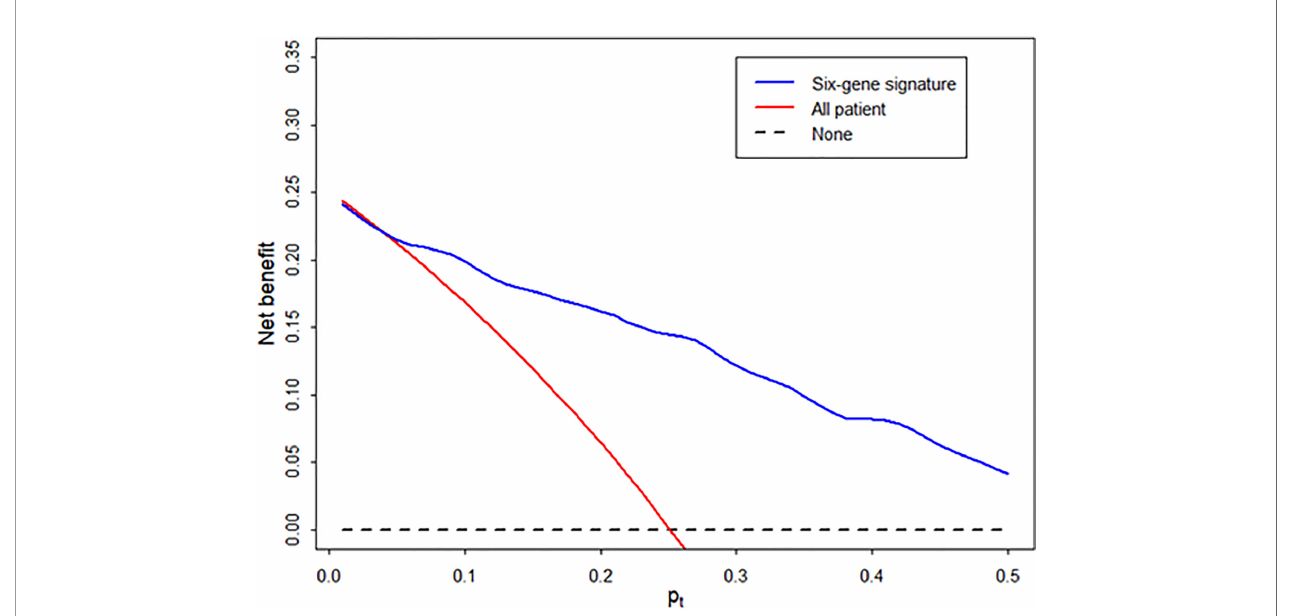
FIGURE 5 | Decision curve to evaluate the clinical bene fi t of the signature to distinguish AR from STA. We performed decision curve analysis to assess the clinical bene fi t of the diagnostic signature using the predicted probability for each patient in independent samples and determined whether the signature can help avoid the number of unnecessary biopsies for the diagnosis of AR. In the decision curve, the y-axis represents the net bene fi t ((true-positive count/n)-(false-positive count/n)x [ p t /(1- p t )]), where the true-positive count is the number of patients with AR, the false-positive count is the number of patients with STA, n is the total number of patients, and p t is the threshold probability. Here, p t /(1- pt) is the ratio of the harm caused by a false positive compared to that caused by a false negative. The blue line represents the net bene fi t of the diagnostic signature. The red line represents the net bene fi t of the biopsy strategy in all patients. The black line, which represents no net bene fi t, is the strategy without